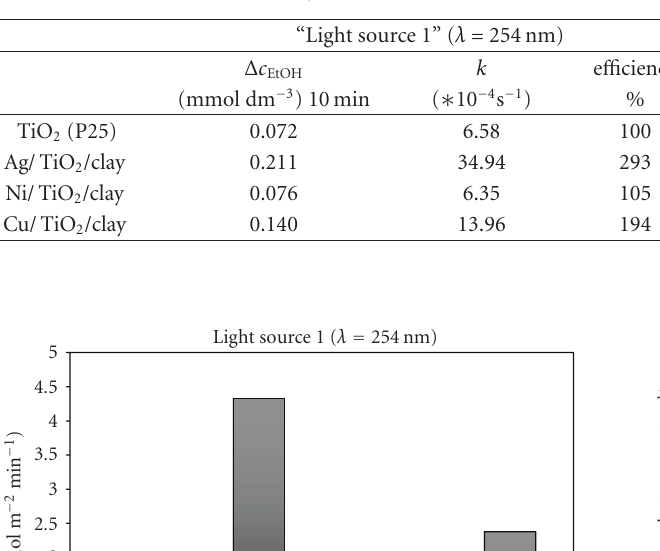
Table 2: Photocatalytical characterization of the TiO 2 (P25) and the transition metal nanocomposite samples.